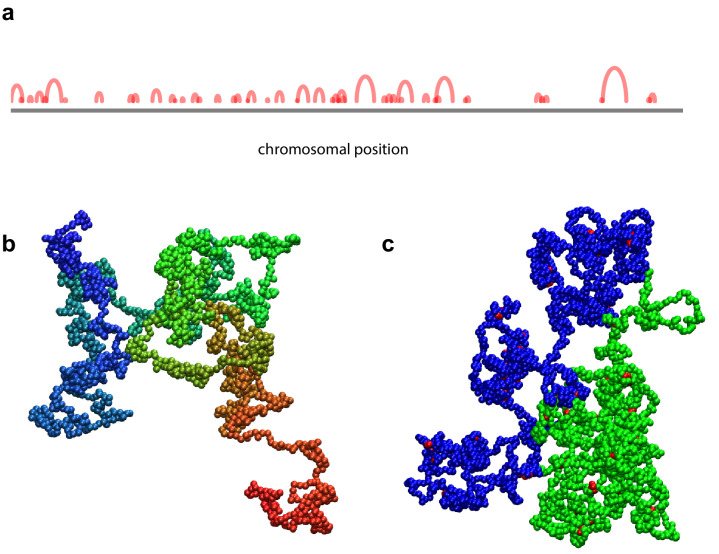
Compaction and resolution of chromosomes with limited loop coverage.(a) Arch diagram for a 1 Mb yeast chromosome with one-sided loop extruders with 40% loop coverage. (b) 3D polymer simulation image of the same chromosome. (c) Spatial resolution of 1 Mb chromatids with 40% loop coverage.